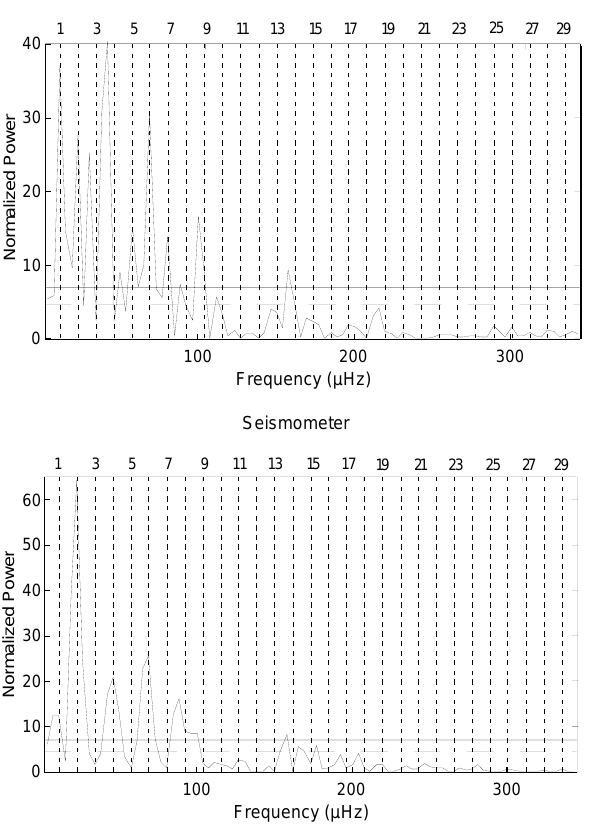
Fig. 6. Fig. 6. Power frequency spectra based on the filtered series for 60– 96h time segment from Fig. 3. The remaining designations are the same in Fig.